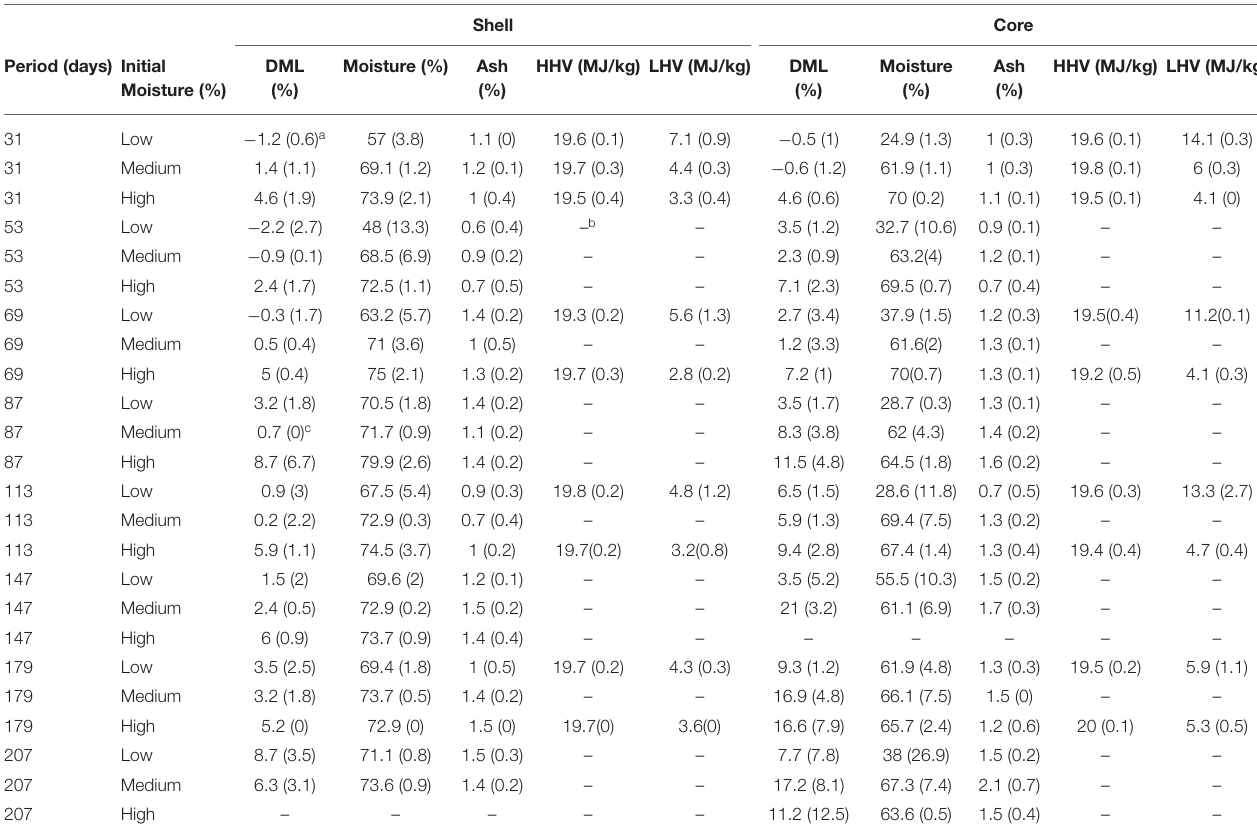
TABLE 6 | Changes in dry matter loss (DML), moisture, ash, and higher (HHV) and lower (LHV) heating value for three initial moisture contents of hot water extracted chips (HC) in the core and shell of a leaf-off willow winter storage pile (first day is December, 22nd 2017). Shell Core Period (days) Initial Moisture (%)